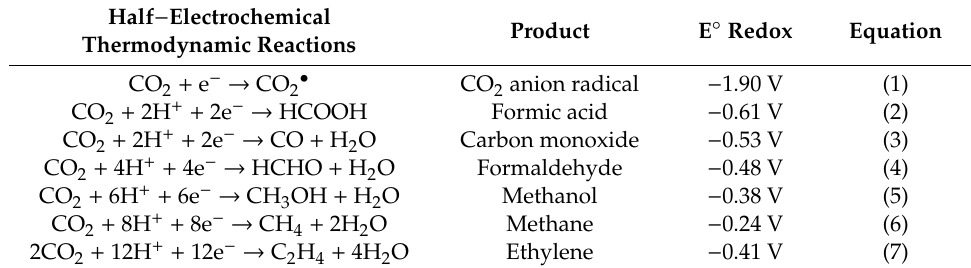
Table 1. The standard redox potentials for the main products of CO 2 reduction in aqueous